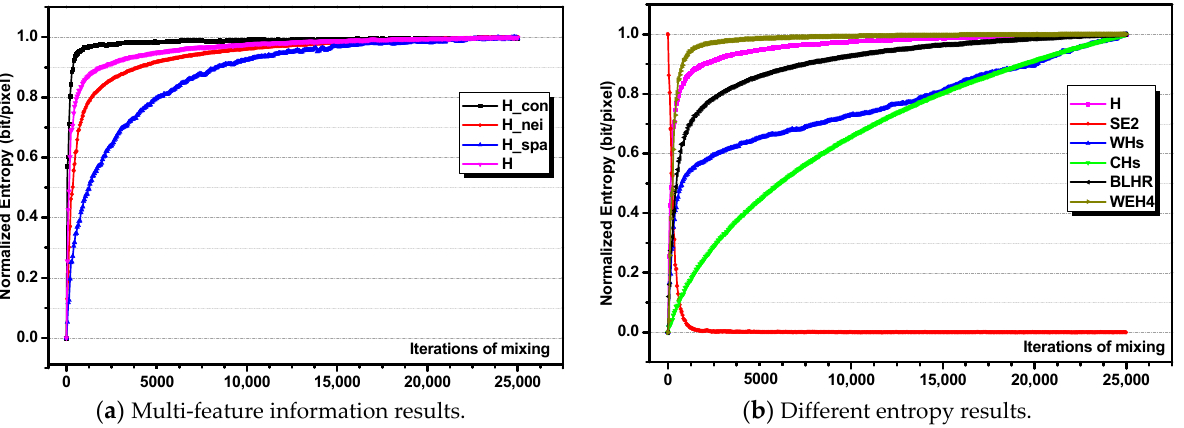
Figure 14. Changes in the entropy of the experimental dataset’s images and the iterations of mixing. ( a ) Normalized image feature information and the comprehensive information results, ( b ) normalized image information results with different entropy methods.